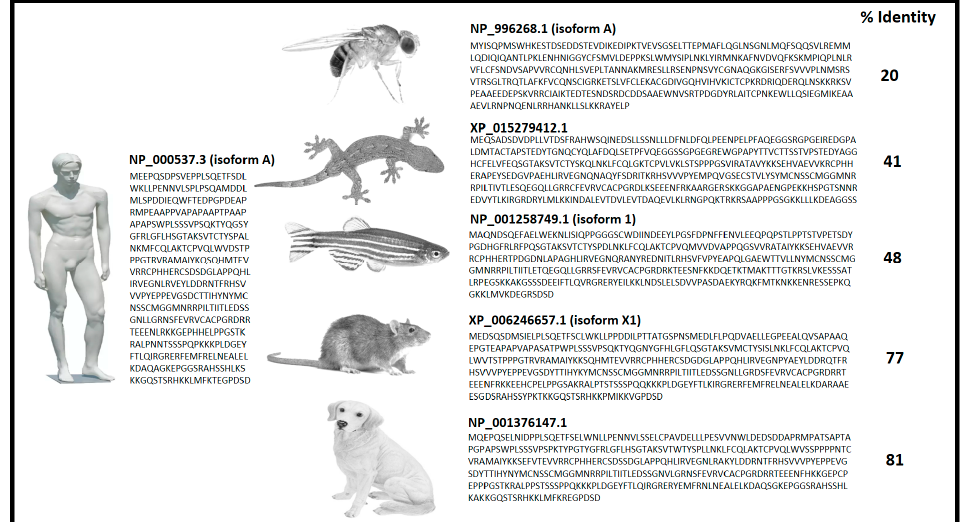
Figure 3. Percent of identity calculated with the Needleman–Wunsch sequences alignment tool (https://blast.ncbi.nlm.nih.gov/Blast.cgi accessed on February 4, 2022) of p53 from different species. Protein ID, isoform and amino acid sequences are depicted for each species.